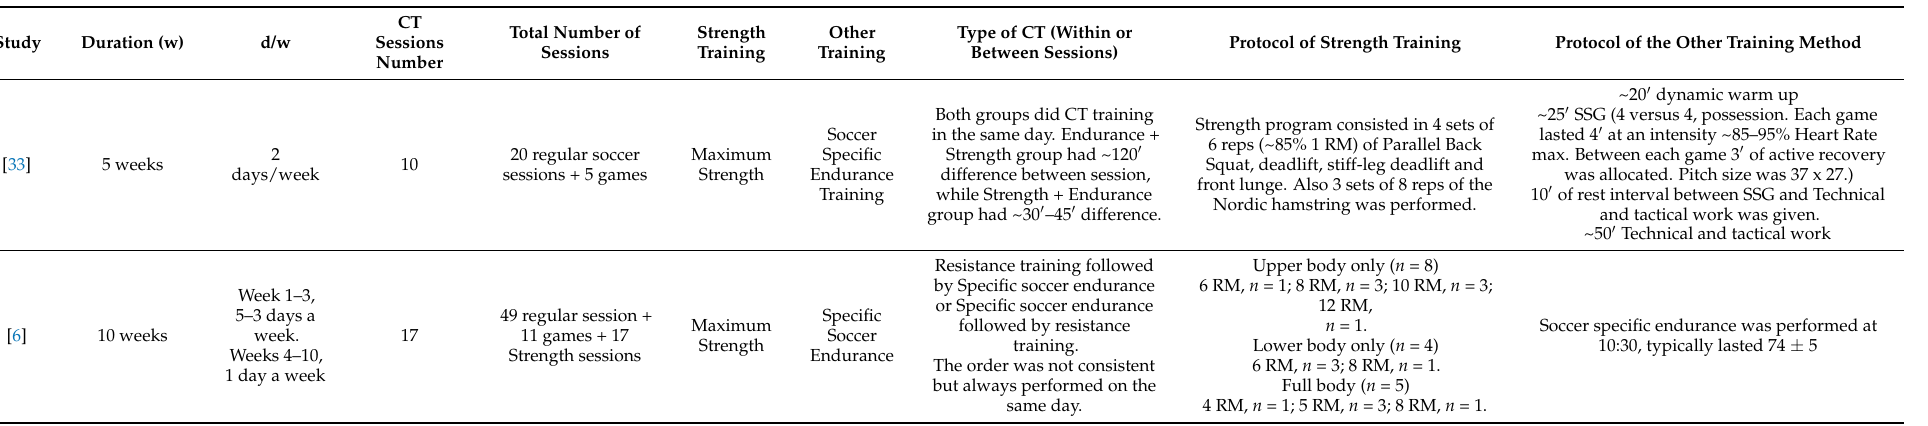
Table 3. Characteristics of CT programmes in the included